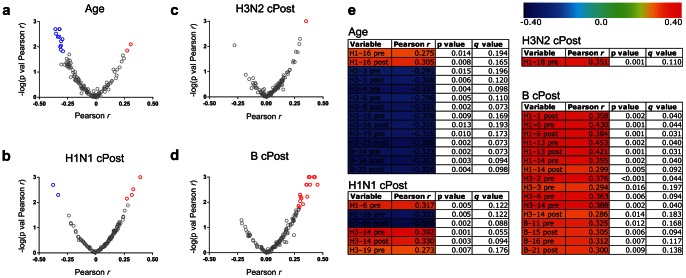
Influenza HA peptide reactivity correlates with age/post-vaccine neutralization titer.(a–d) Volcano plots displaying significance of the Pearson r correlation coefficient “−log(p value Pearson r)”, corresponding to the relationship of (a) age; (b) H1N1 cPost; (c) H3N2 cPost; and (d) B cPost neutralization titer with pre- and post-vaccine reactivity to H1N1, H3N2 and B-strain peptides. The Pearson r correlation coefficient is plotted on the x-axis. Red and blue color represents positive or negative correlation, respectively, of associations with a q value determined to be less than 0.2. Gray color indicates peptide associations that were not significant. (e) Table and heatmap displaying correlation coefficient (Pearson r), p value and false discovery rate (FDR) q value of the significant peptide reactivity shown in a–d with age, H1N1 cPost, H3N2 cPost, and B cPost. Color scale represents the direction and magnitude of the Pearson r correlation coefficient. See tables S3, S4, S5, S6, for the statistical results of all comparisons.